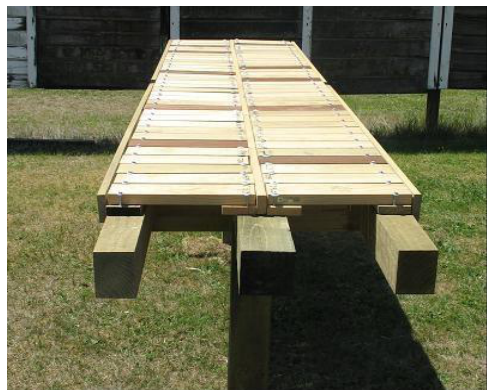
Figure 3. Raised decking test at installation showing treated bearers and battens at the outer ends of the samples and untreated bearers plus separating strip in the centre. For the ground-level decking test, the treated bearers were placed directly on the ground, but other details were the same as for raised decking.